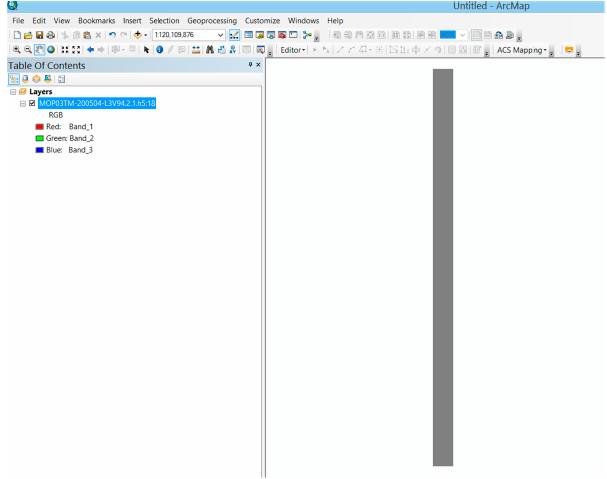
Figure 3. Display error for the 3D EO data in ArcGIS.